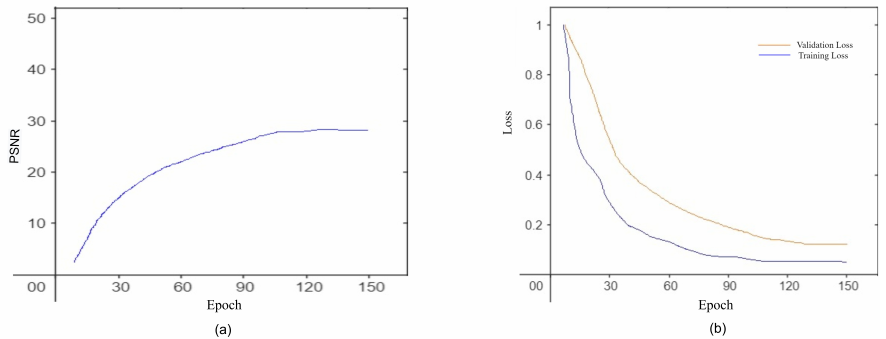
Figure 9. ( a ) PSNR VS Epoch Curve, ( b ) Loss VS Epoch Curve [ β 1 = 0 : 82 and β 2 = 0 : 99, Adam optimizer, 21 batches, 150